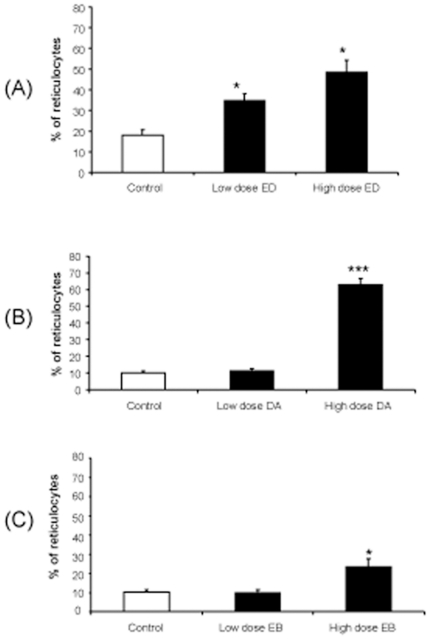
Percentage of reticulocytes as an early indicator for erythrogenesis.The percentage of reticulocytes were analysed as an early indicator for erythrogenesis and these cells were significantly increased by low dose of Epoetin Delta and high dose of Epoetin Delta (A) when compared to control animals (n = 6)) (*p<0.05). Darbepoetin Alfa (B) (***p<0.001) and Epoetin Beta (C) (*p<0.05) only altered the percentage of reticulocytes with the high dose of EPO. (Error bars  =  Standard Error of the Mean).